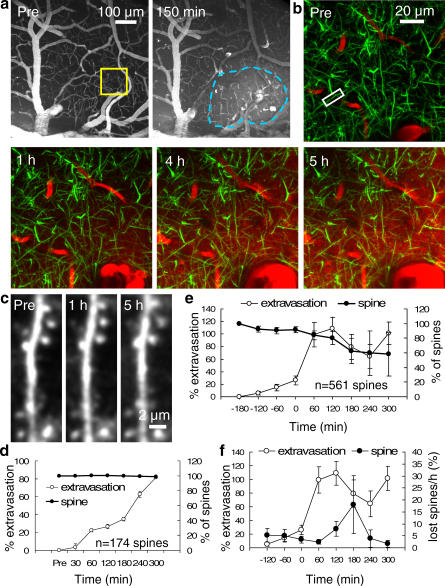
No Relationship between Accelerated Extravasation and Loss of Spines after RB Photothrombosis(A) Low-magnification image of the vasculature (maximal intensity projection, 50 μm) before and after photoactivation of RB. A total of 24% percent of vessels were clotted over an ischemic area of 0.05 mm2.(B) Shown are two channel images (a subregion Z-projection) from the boxed region in (A) showing the vasculature (red) and YFP-labeled dendrites (green) before and 1, 4, and 5 h after photoactivation of RB. Vessels were labeled with TR-dextran. The red fluorescence in the tissue indicates extravasation or leakage of plasma containing TR-dextran.(C) A higher-magnification view of a dendritic segment (box in [B]) showing no significant damage or loss of spines despite time-dependent acceleration in extravasation.(D) Quantification of extravasation and spine number over time for this animal. Extravasation was quantified by determining the percentage of vessel TR-dextran fluorescence intensity present in the tissue. Spine number expressed as percentage of the number present before RB photoactivation (n = 174 spines). These data indicated that small strokes are not associated with any significant change in spine number over a 5 h period despite a significant increase in extravasation.(E) Group data from nine different animals show relative changes in extravascation and spine number (data aligned by the timepoint when the maximal rate of extravasaton was observed; set as the 0 timepoint) after RB stroke. A one-way analysis of variance indicated a significant effect of time on both spine loss and extravasation. Individual timepoints were compared to the 0 timepoint using Dunnett's post hoc test. We did not observe a significant change in spine number when the rate of extravasation was maximal.(F) There was no significant correlation between the rate of spine loss, change in spine number between consecutive 1-h timepoints, and extravasation at different times (r
2 = 0.02; p = 0.75; nonparametric Spearman correlation coefficient; same data as [E] analyzed differently).